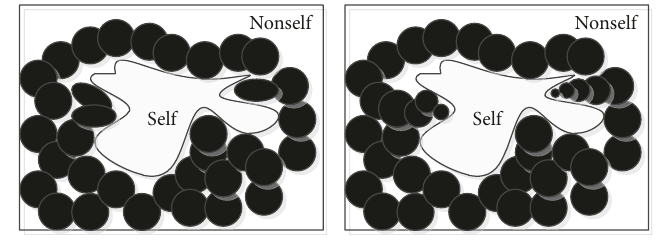
Figure 2: Solutions for the first kind of holes.